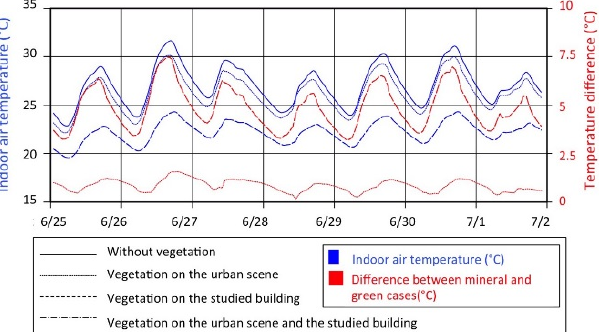
Figure 8. Indoor temperatures of the third floor (in blue ) and the difference with the mineral case (in red ). Nota bene (N.B.): the results of the cases “vegetation on the studied building” and “vegetation both in the urban environment and on the studied building” are superimposed.